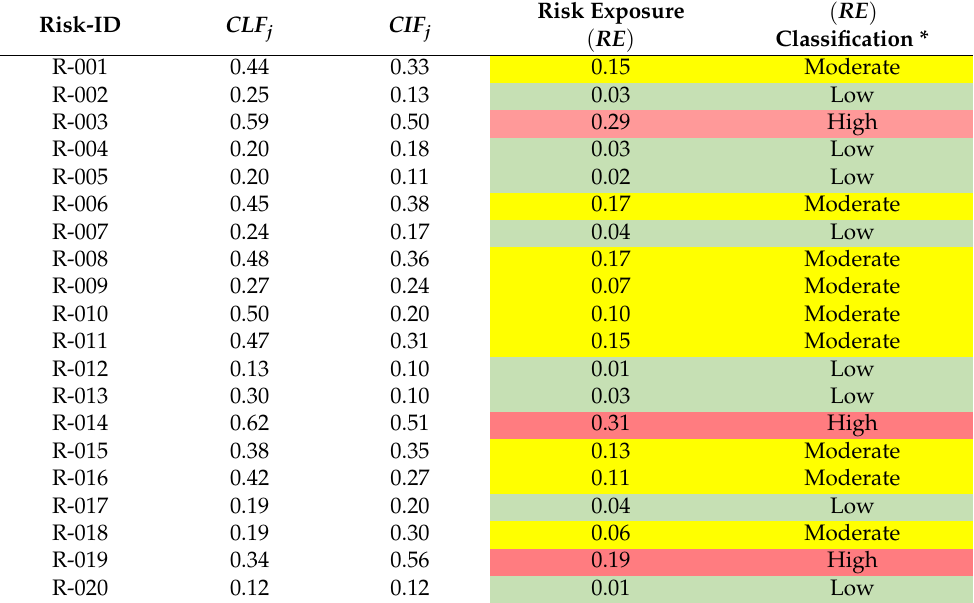
Table 11. Risk exposure ( RE j ).